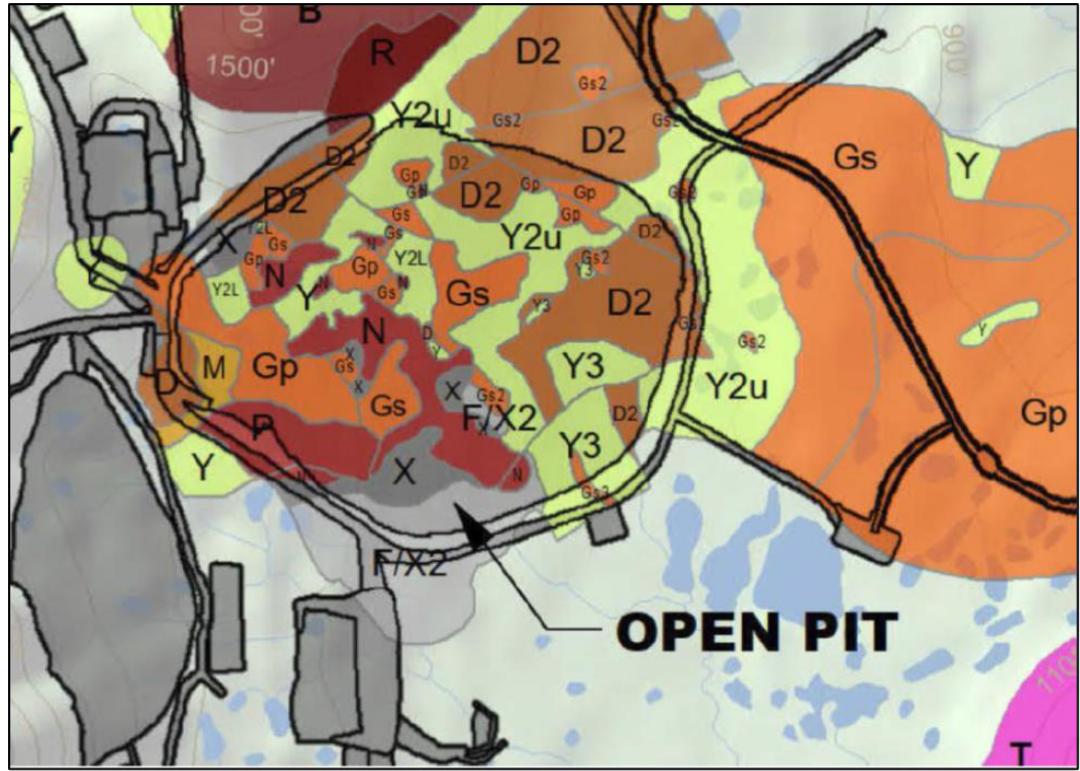
Figure 4. Bedrock geology map of the pit area. All rock units in the pit are Pre-Tertiary units or fault or intrusion breccias. The only Tertiary rocks, shown in magenta with a “T,” are located southeast of the pit. Source: [15] (FEIS, Figure 3.13-3).